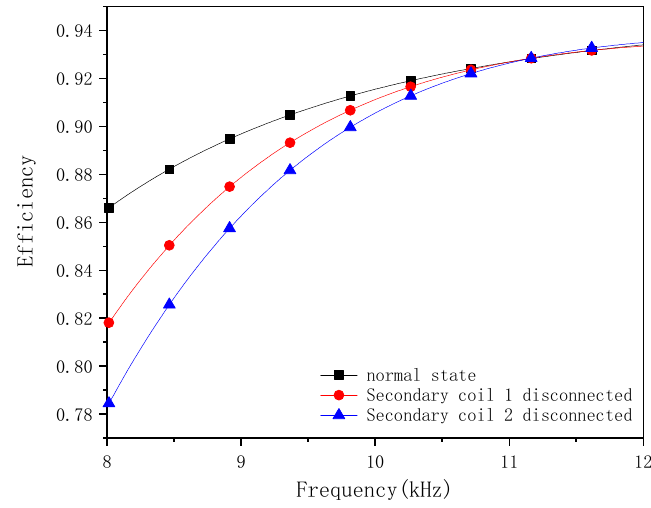
Figure 11. The efficiency of the secondary coil in normal and faulty conditions.